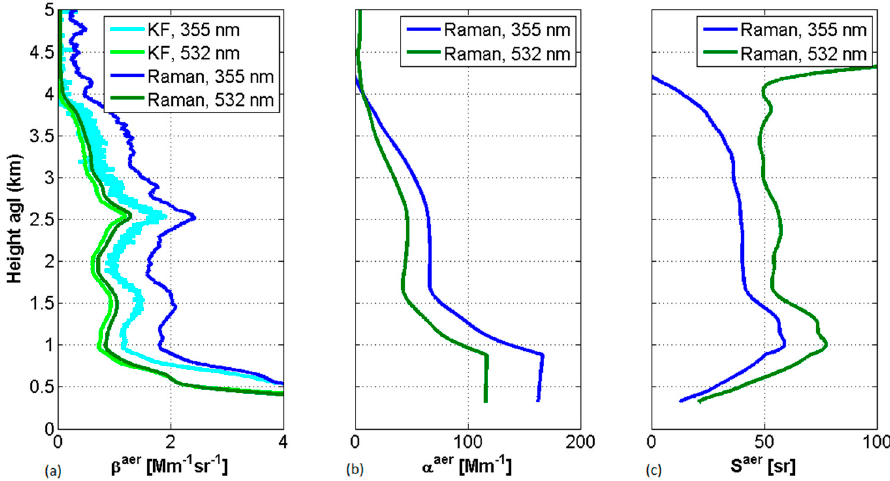
Figure 3. Example of retrievals of aerosol optical properties: ( a ) backscatter coefficient from KF (with a constant lidar ratio of 50 sr) and Raman algorithm; ( b ) extinction coefficient from Raman algorithm; and ( c ) lidar ratio from Raman algorithm. The data are from a Saharan dust intrusion detected in Barcelona, Spain, on 28 May 2016, with the multi-wavelength lidar system from the Universitat Politècnica de Catalunya (UPC).